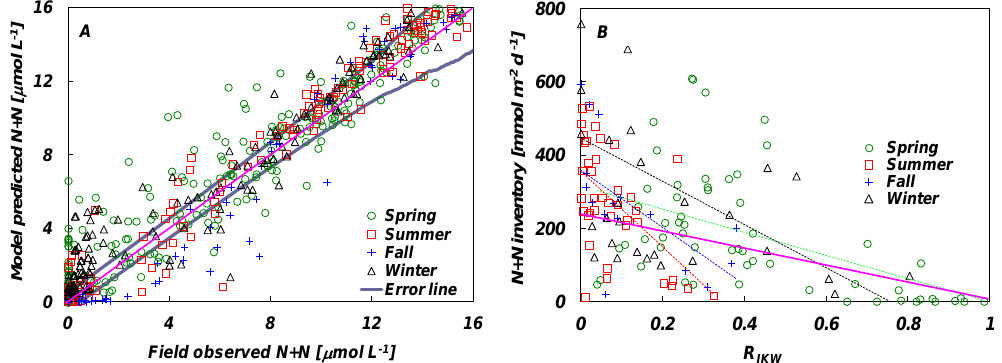
Fig. 9. (A) The model-predicted N + N concentrations versus the field measurements in the upper 100m of the central northern South China Sea (NSCS). Pink line is the 1:1 line while gray lines donate the X r ± S r domain; (B) The relationship between the field observed N + N inventory and the station-integrated Kuroshio water fraction ( R IKW ) . The solid pink line is the theoretical mixing line constructed by the N + N inventory of the SCS and Kuroshio endmembers ( ∼ 250mmolm − 2 in NSCS and ∼ 5mmolm − 2 in Kuroshio, respectively, which is obtained by supposing the mixing R KW is the same value in the entire upper 100m). The dotted lines with the different colors represent the corresponding linear regressions from different